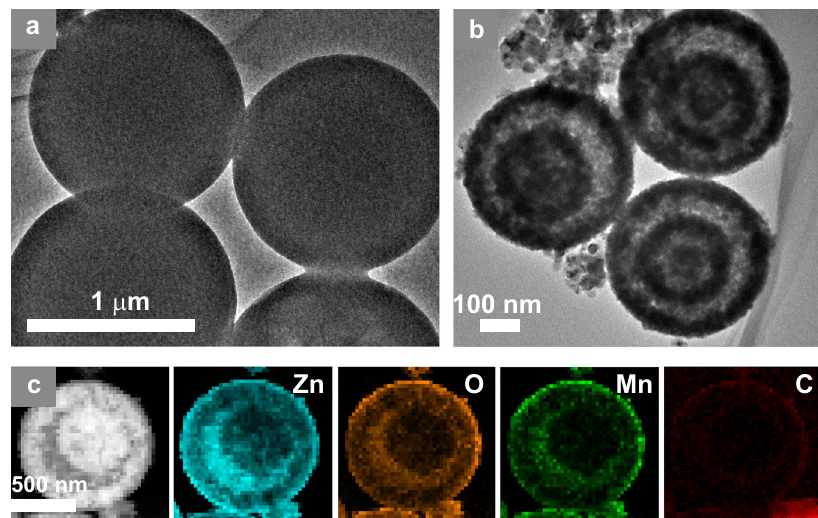
Fig. 2 Morphology of the prepared materials. TEM images of the Mn, Zn-CPSs a before calcination and b after calcination for 3 h. c HAADF-STEM image of Mn, C-ZnO and EDS mapping of the sample show the constituent elements Zn, O, Mn, and